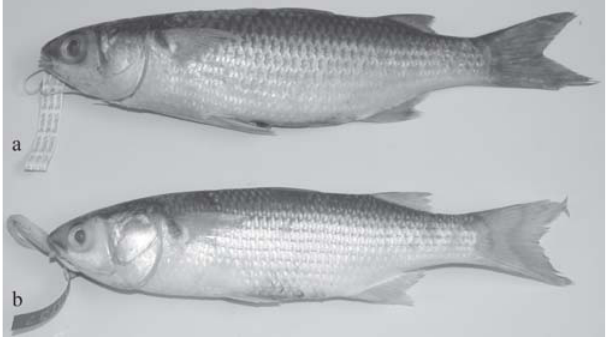
Fig. 1 . Specimens of M. curema from (a) Brazil and (b) Ven- ezuela preserved in